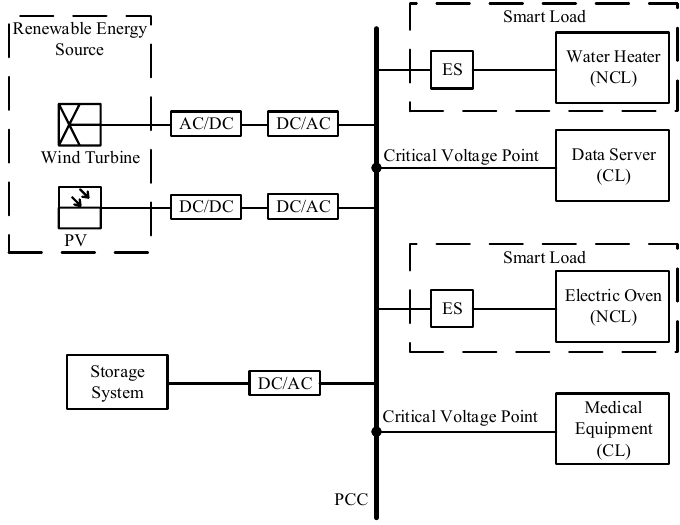
Figure 8. Schematic of microgrid with distributed